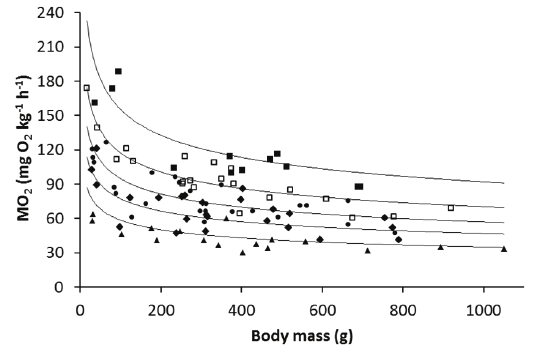
Figure 1 - Specific standard metabolic rate (SMR) of pacu as function of body mass (M) and water temperature (T). Temperatures: 19 ºC (▲), 23 ºC (♦), 26 ºC (●), 29 ºC (□) and 33 ºC (■). Fitted model: SMR = 42.765×M −0.22312 ×e (0.0702× T ) (r 2 = 0.84, n =